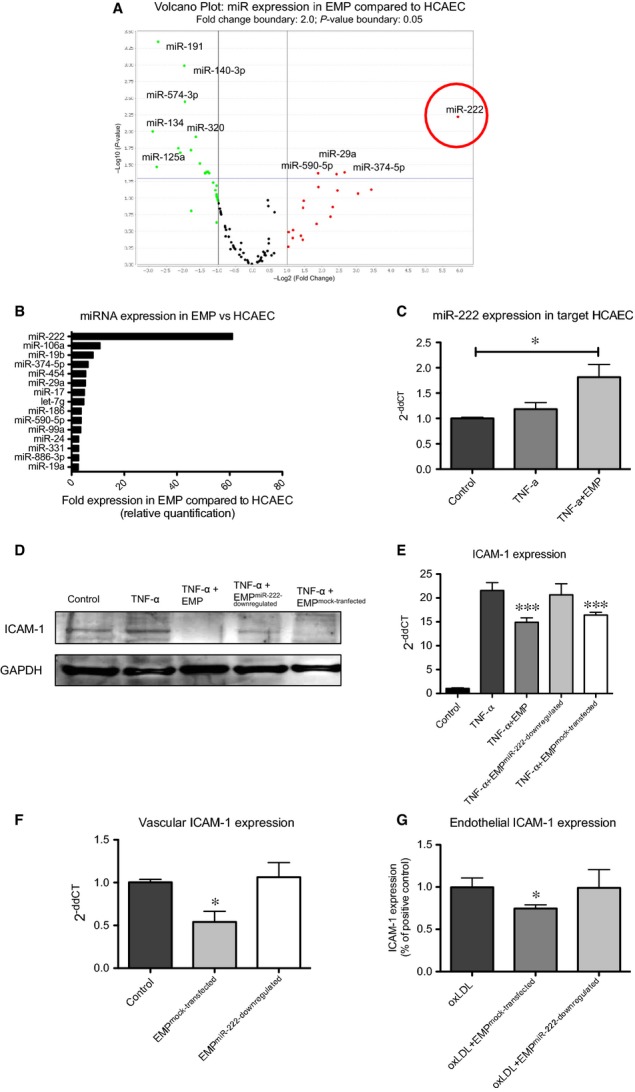
EMP contain and transfer functional miR-222 to endothelial target cells. (A) Volcano plot of microRNA profile in EMP and HCAEC as determined via TaqMan miRNA array (n = 3). Right vertical line represents the border for twofold change in miR expression [points on the right side of that line symbolize miRs that are >2 ×  higher expressed in EMP versus HCAEC (log2)]. Horizontal line displays the border for significant regulation. Points above that line represent significantly regulated miRs (P < 0.05(−log10)). (B) Top 15 miRs higher expressed in EMP compared to HCAEC. RNU6 was used as endogenous control. (C) Expression of miR-222 in HCAEC detected by Taqman microRNA assay, RNU6 was used as endogenous control, *P < 0.05, n = 6–8. (D and E) EMPmiR-222-down-regulated were derived from miR-222 inhibitor-transfected parent cells. HCAEC pre-treated with EMP, EMPmiR-222-down-regulated, EMPmock-transfected or vehicle were stimulated with TNF-α or vehicle for 24 hrs. (D) ICAM-1 expression was analysed by Western blot. (E) ICAM-1 mRNA levels were analysed by real-time PCR. 18s was used as endogenous control, ***P < 0.001, n = 8. (F) ICAM-1 mRNA levels from ascending aortas from ApoE−/− mice were analysed by real-time PCR. 18s was used as endogenous control, *P < 0.5, n = 8–10. (G) ICAM-1 mRNA levels from HCAEC treated with 20 μg/ml oxLDL and with or without EMP were analysed by real-time PCR. 18s was used as endogenous control, *P < 0.05 versus oxLDL and EMPmiR-222-down-regulated, n = 8.